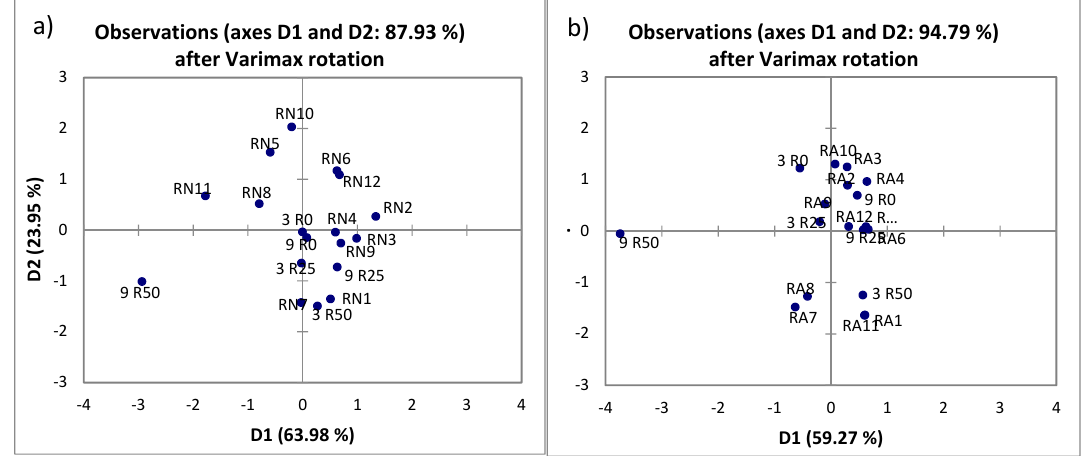
Figure 4. The principal component analysis (PCA) of rosemary extracts: ( a ) The data is denoting untreated rosemary samples, and rosemary samples treated with HVED using nitrogen; ( b ) The data is denoting untreated rosemary samples, and rosemary samples treated with HVED using